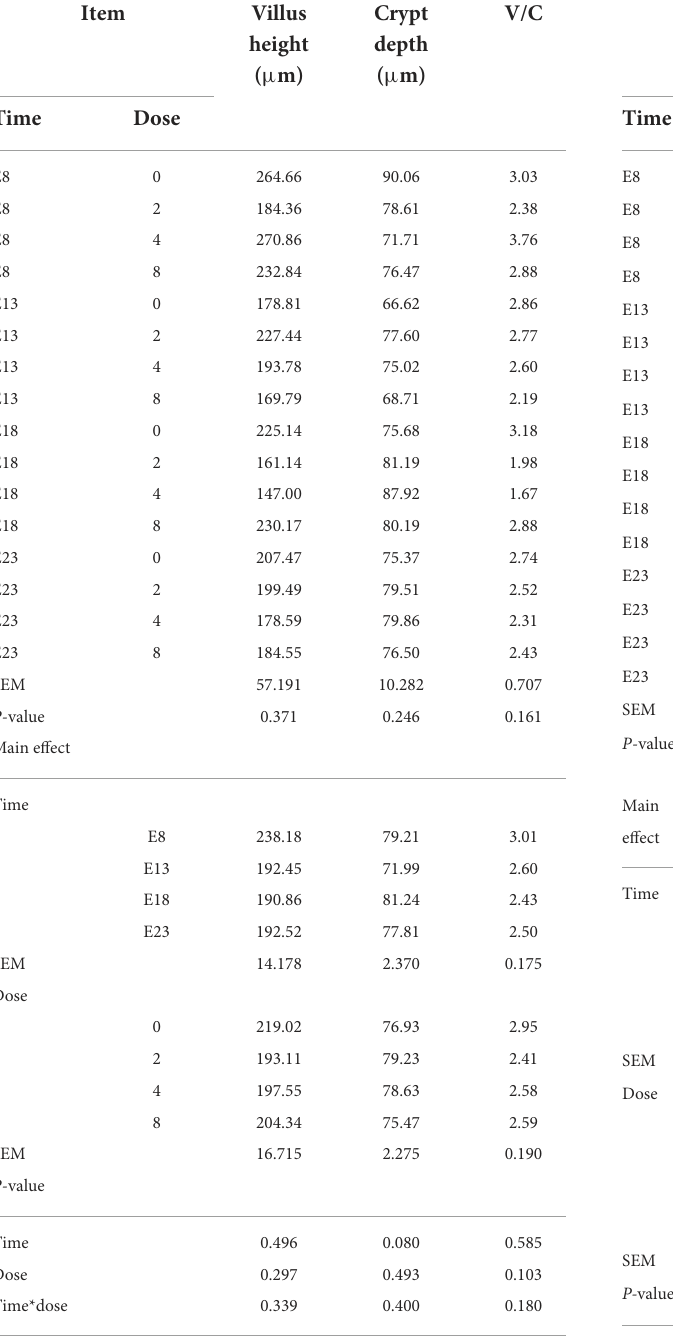
TABLE 4 Effect of time and doses of an embryo injected OTA on the TABLE 5 Effect of time and doses of an embryo injected OTA on the jejunal morphology of ducks at hatching 1 . jejunal antioxidant capacity of ducks at hatching 1 . Item Villus Item SOD AOC Crypt V/C height (U/mgprot) depth ( µ m) ( µ m)